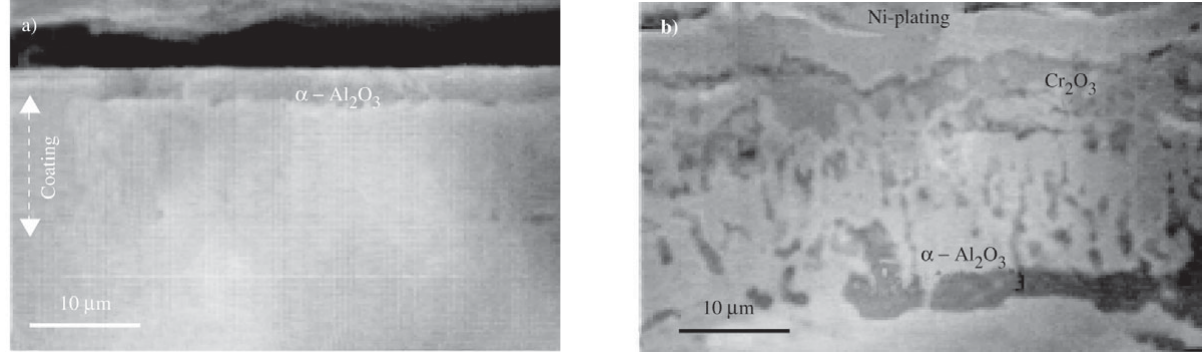
Figure 10 . Cross-section of Ni-20Cr-2Al coating samples after oxidation at 1000 °C for 100 h: a) coating grain size ~60 nm; b) coating grain size ~370 nm.